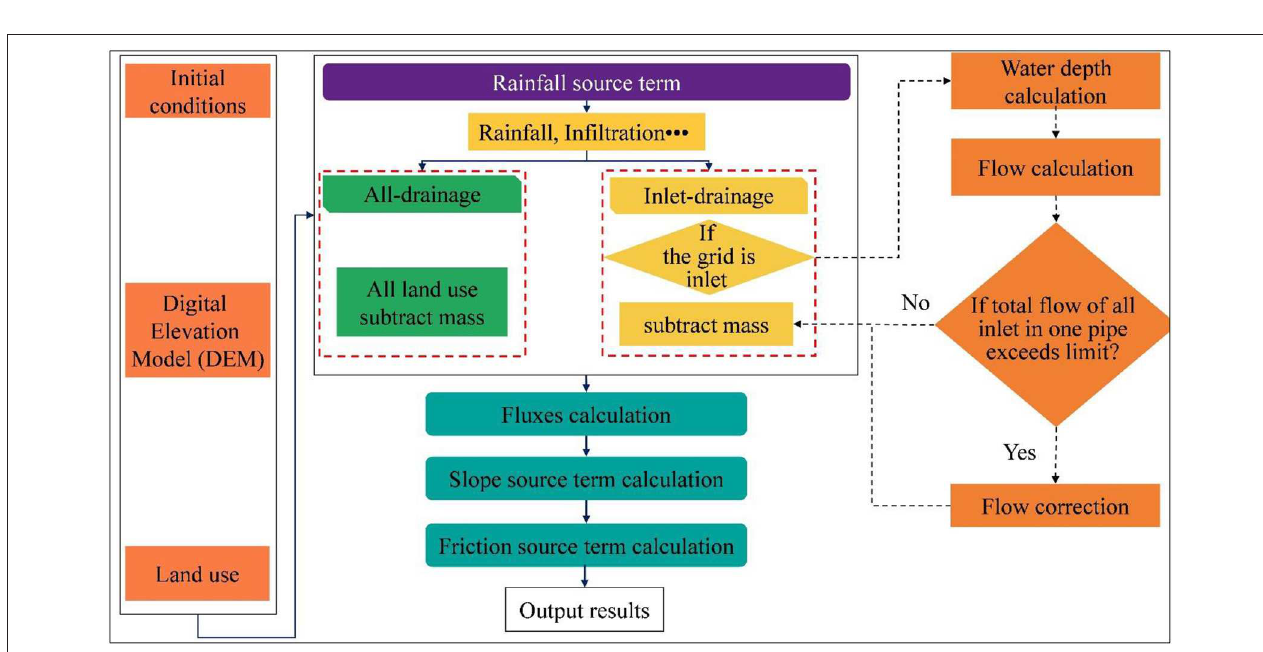
FIGURE 4 | Flow diagrams of the new approach and the existing